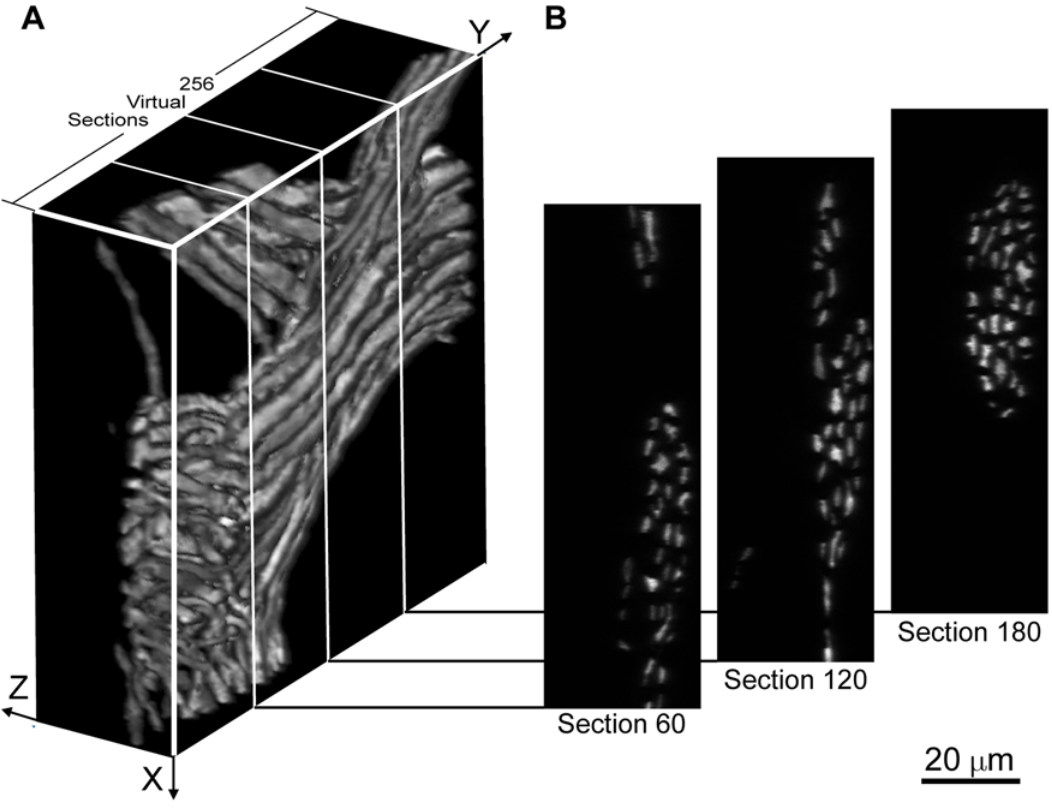
Figure 1. Re-sampling of a XY stack along the Y axis. A . A fluorescent image stack rendered as volume data. The raw data set contained 159 z- direction optical sections. Each section is a 1024 6 1024 image. X-Y pixel size: 0.10 6 0.10 m m; z-step size: 0.20 m m. B . En face view of three virtual sections generated by resampling the stack in A along the Y-axis at positions schematically indicated by white lines in A .